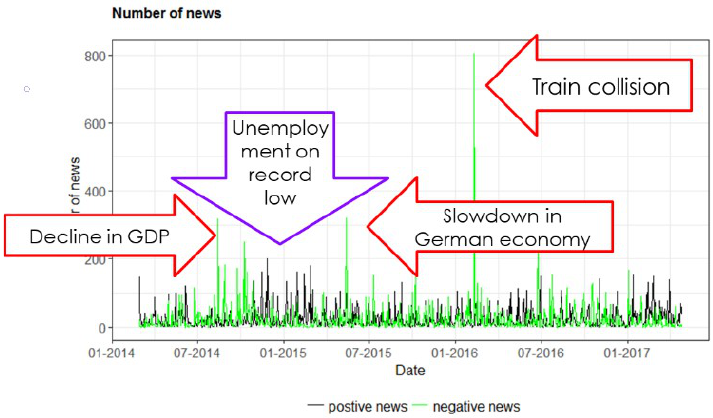
Figure 1. Daily news volume from entity “Germany” between 2014 and 2017.